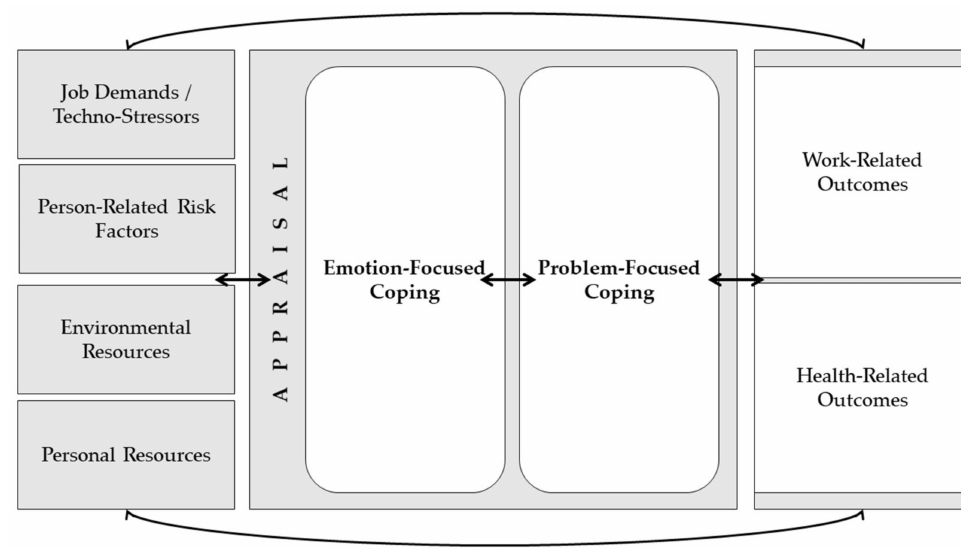
Figure 1. Occupational psychological stress model (adapted based on Bamberg et al.